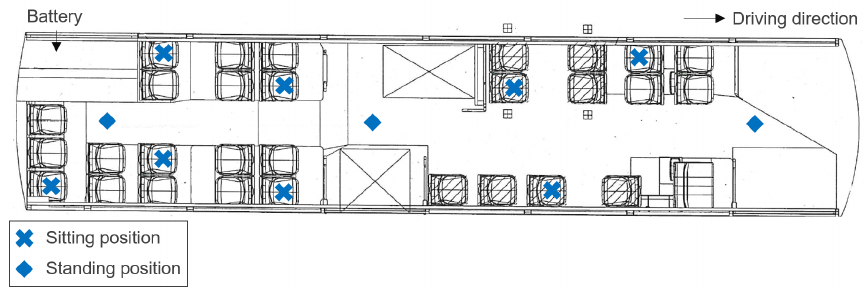
Figure 4. Positioning of the sensor stations in the